Question: Sum up the contents of this chart in one sentence.
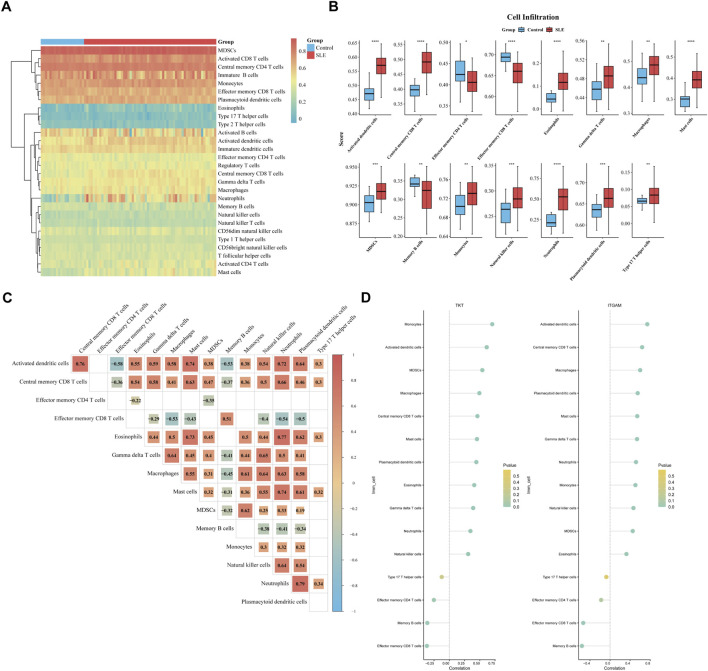
Answer: Immune cell analysis in SLE and control samples. (A) The ssGSEA scores visualized the proportions of 28 immune cell types in the peripheral blood from SLE patients and healthy controls. (B) Boxplots identified significant differences in 15 immune cell types, including activated dendritic cells, effector memory CD4 T cells, memory B cells, eosinophils, and neutrophils (p < 0.05). (C) Correlation analysis revealed significant interactions among immune cells present differentially. (D) ITGAM and TKT showed significant correlations with immune cells. ITGAM was positively associated with activated dendritic cells (R = 0.742) and negatively with memory B cells (R = −0.562), while TKT was positively correlated with monocytes (R = 0.704) and negatively with effector memory CD8 T cells (R = −0.367) (p < 0.05).